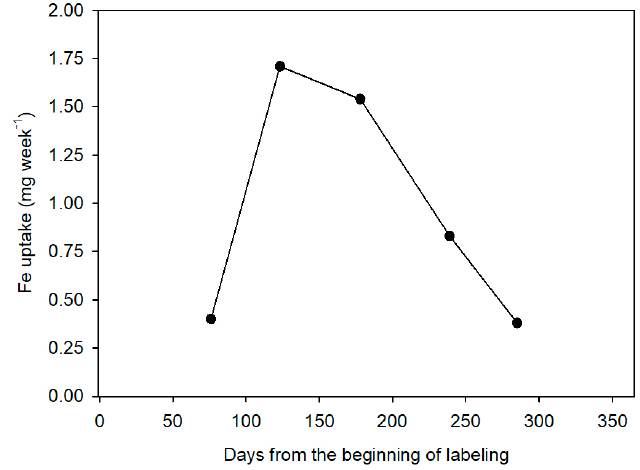
Figure 3. Weekly Fe uptake rate (Fe absorbed from fertilizer week − 1 ) measured from the beginning of labeling (March 1) in Nules clementine trees. Each point represents one phenological moment of the plant cycle when plants were uprooted: May (flowering), July (fruit set and the end of fruit drop), August (fruit growth), October (fruit growth), and December (fruit maturity). Values are means of 4 plants.